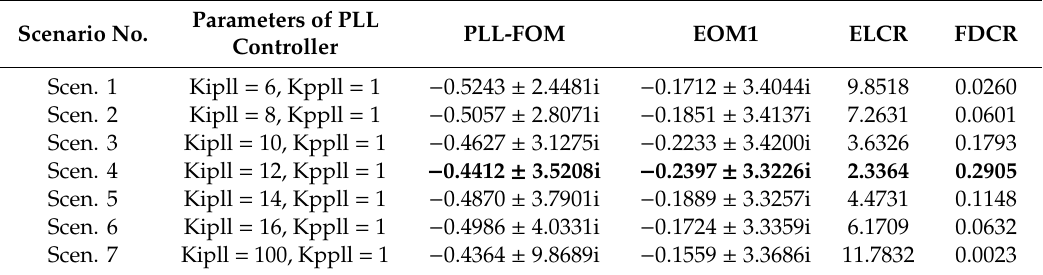
Table 2. Di ff erent scenarios with respect to PLL-FOM under 50% FCWG penetration level. Scenario No.